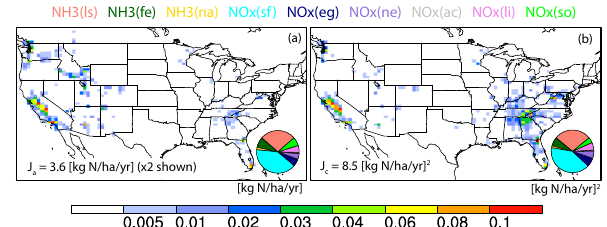
Figure 10. Same figure as Fig. 5 but with different cost functions. (a) J a , the sum of Nr deposition in all Class I areas in CL ex- ceedance, (b) J c , the sum of square of the difference of annual Nr deposition and CL in all Class I areas in CL exceedance. Sensitivi- ties of (a) are scaled by × 2 to share the colorbar with (b)